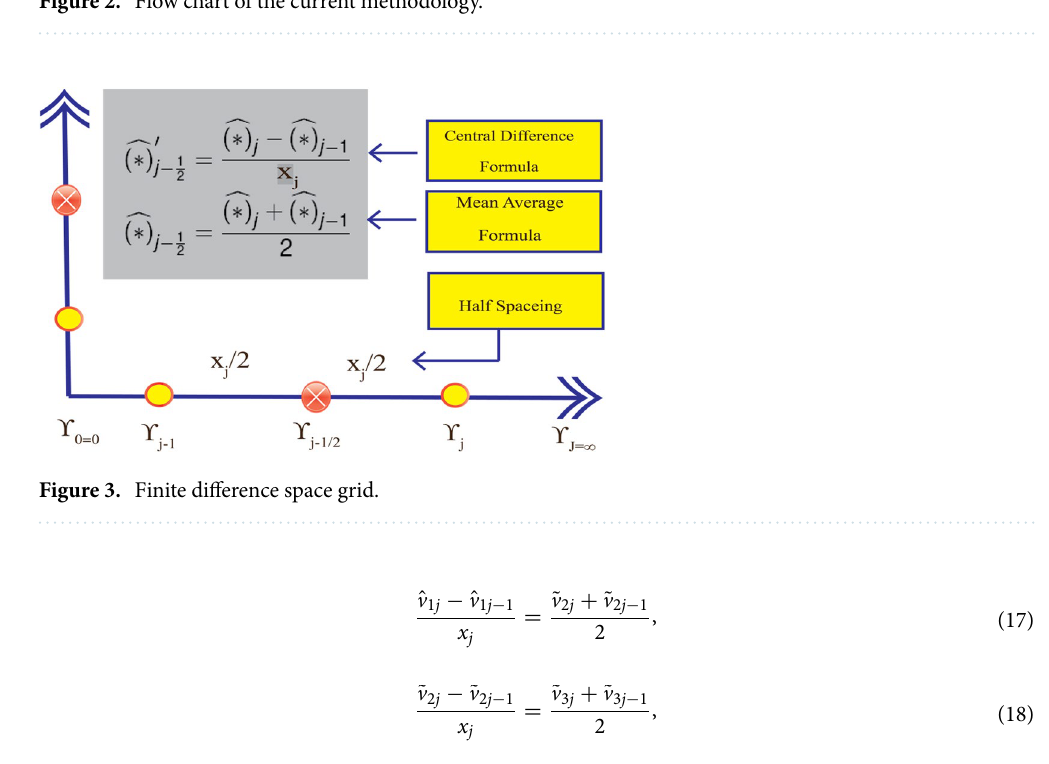
Figure 2. Flow chart of the current methodology.